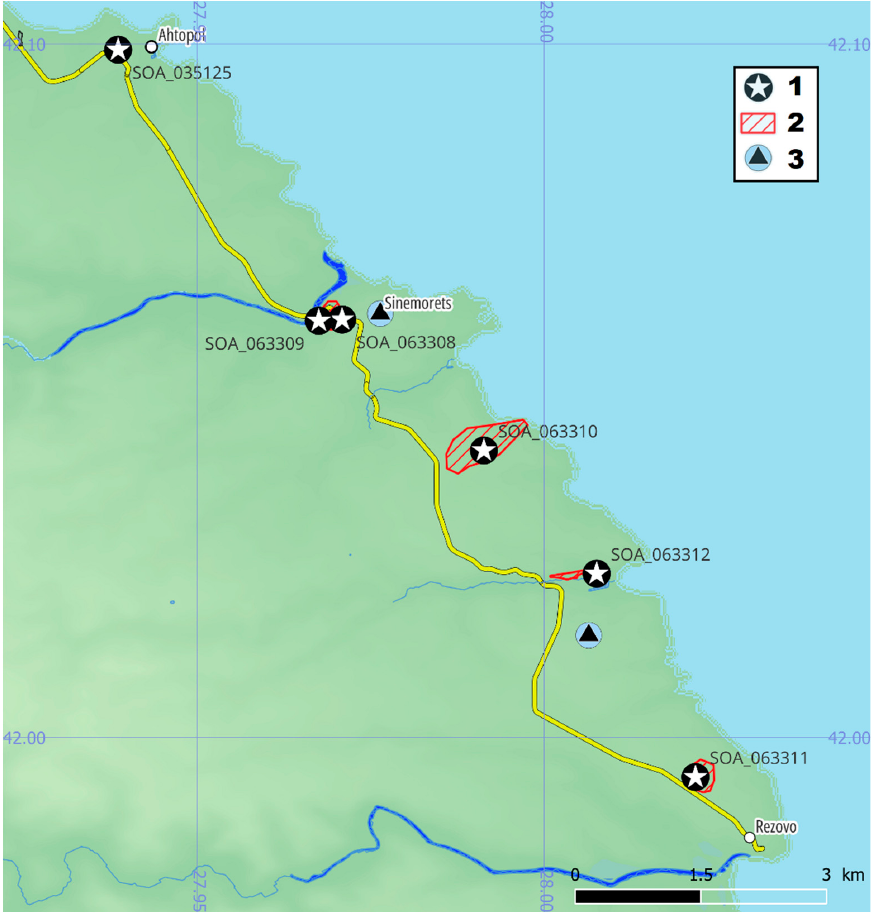
Figure 4. Specimens of C. speciosus subsp. ibrahimii from Bulgaria: (1) collected specimens; (2) observed specimens; (3) data entries of C. pulchellus.